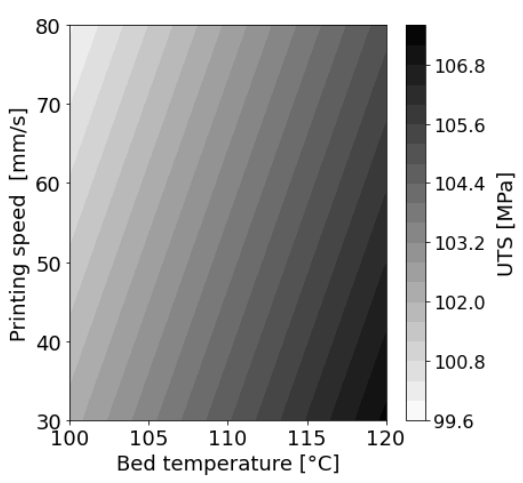
Figure A3. Contour plot for T ext and T bed based on DoE prediction model.